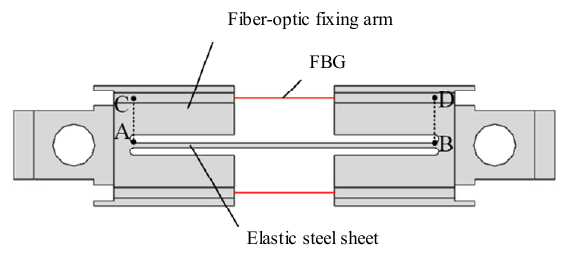
Fig. 2 Structure of the elastomer.